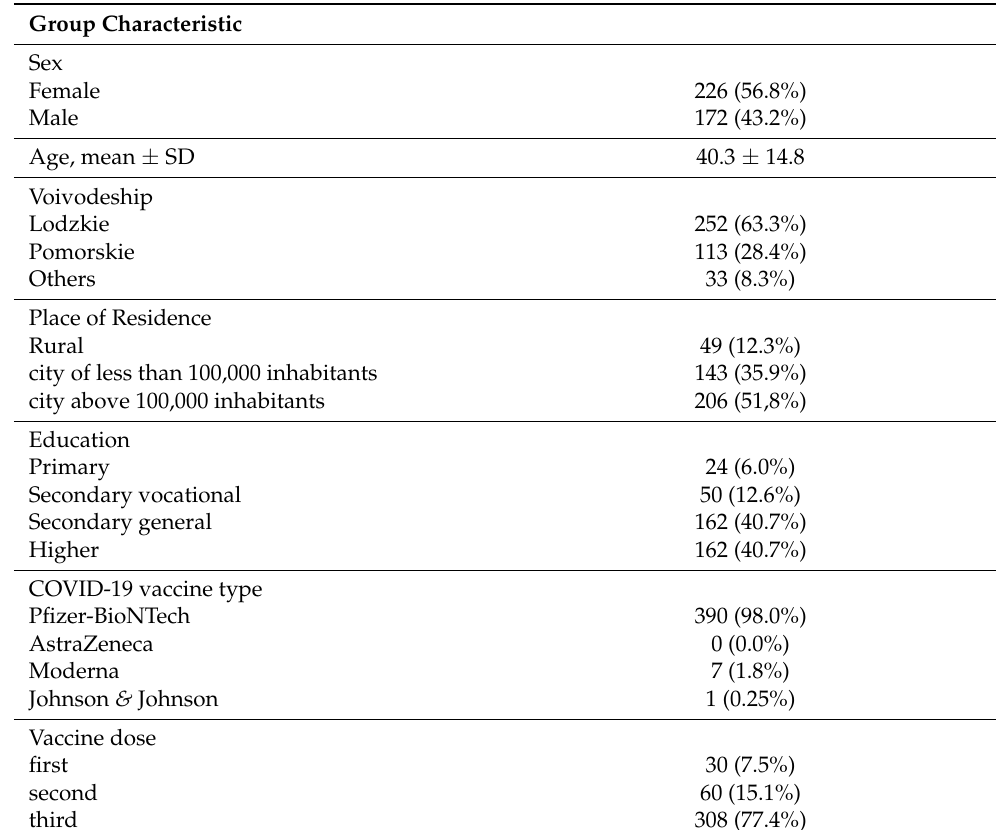
Table 1. Demographic characteristic of